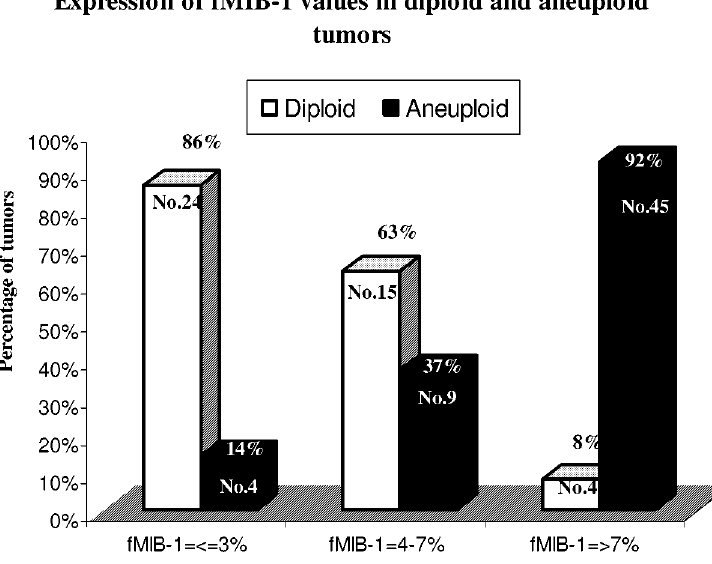
Fig. 8. Expression of flow MIB-1 values in diploid and aneuploid tumors.